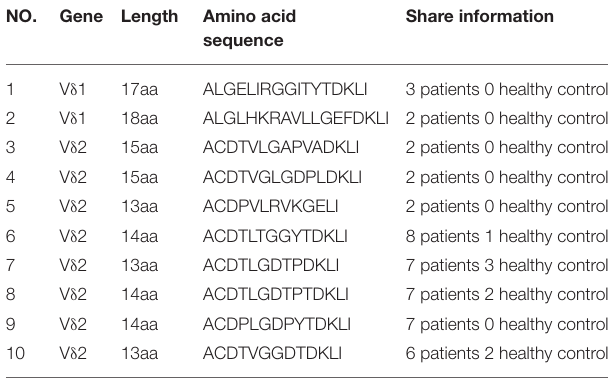
TABLE 2 | CDR3 δ sequences in healthy controls and TB